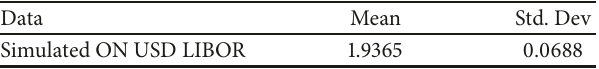
Table 4: Descriptive Statistics of the Simulated 3 Month USD